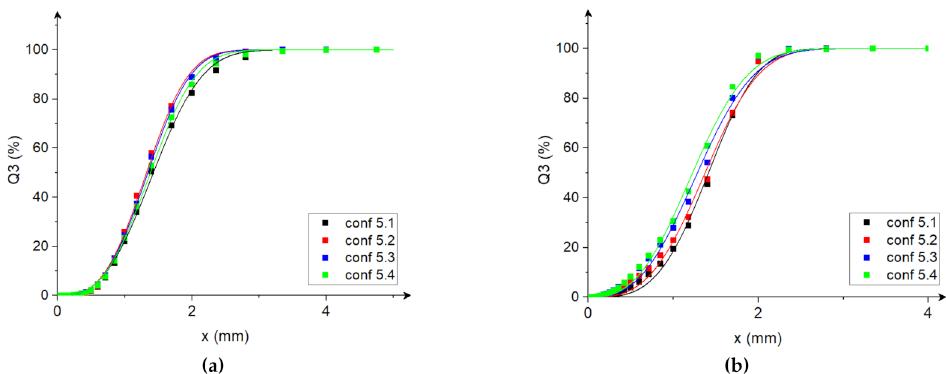
Figure 5. Cumulative particle size distributions of the ground product for the tested configurations of disc angular velocity settings with the fitted RRSB distribution curves; ( a ) corn grains and ( b ) rice grains. The solid lines are the fitted RRSB distributions, conf. means the configuration of the disc